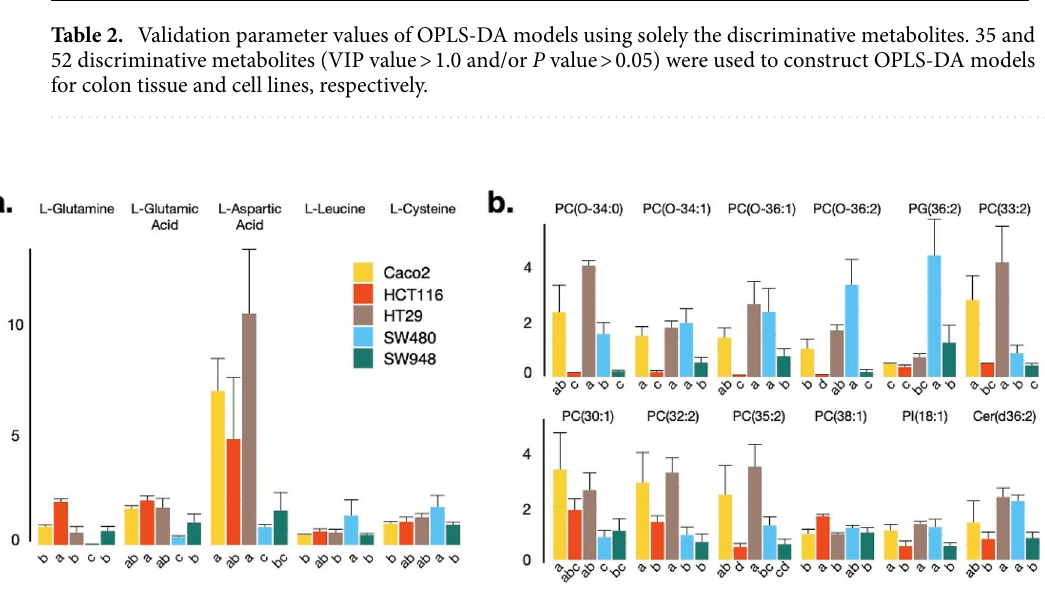
Figure 2. Significantly altered metabolites between different transformed cell lines: ( a ) polar metabolites and ( b ) lipids. Normalization was performed by dividing the peak area (expressed in arbitrary units) of a specific component in a sample by the mean peak area of that component in the next two QC samples that were run after every ten samples. Cell lines assigned with different letters are statistically ( P value < 0.05) different from each other. Error bars represent standard deviations (n = 3